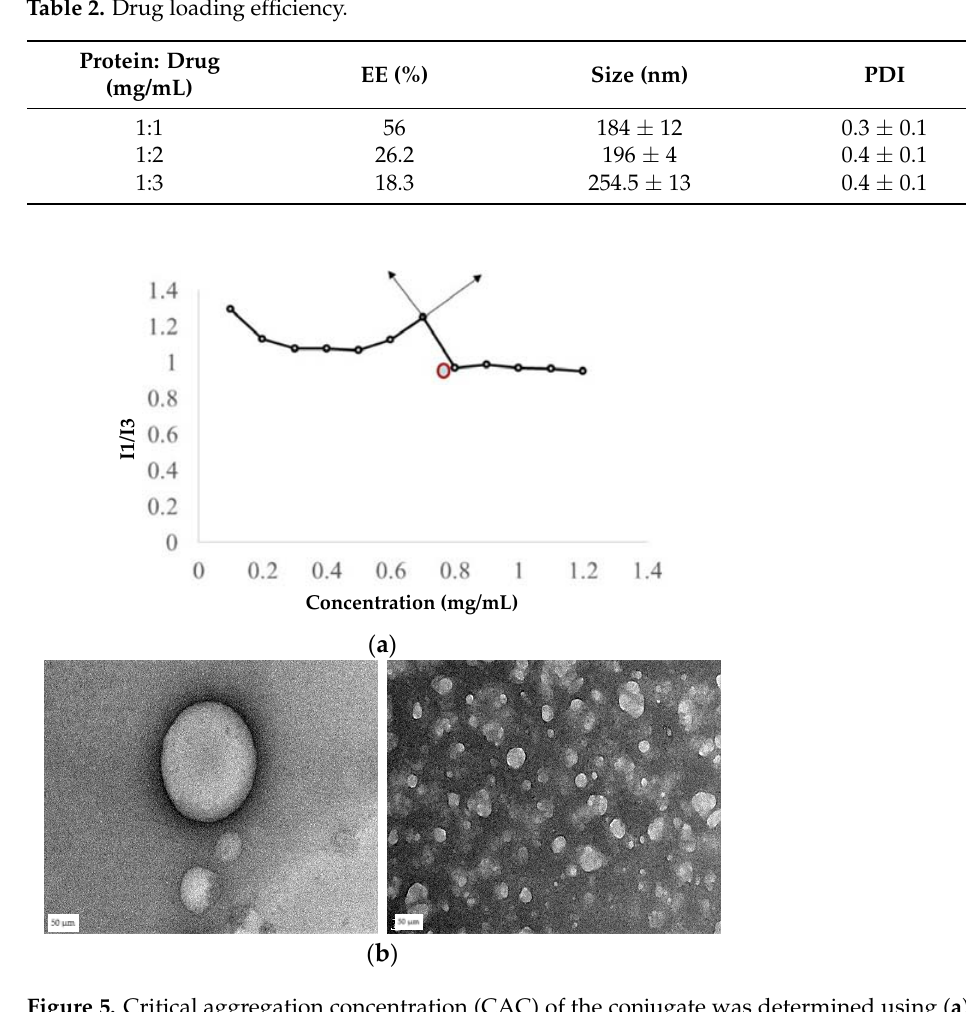
Figure 5. Critical aggregation concentration (CAC) of the conjugate was determined using ( a ) the standard pyrene fluorescence method. The concentration at the tangent on the graph, which shows a sudden fall in the intensity ratio, corresponds to the CAC (0.7 mg/mL). ( b ) TEM images of Vancomycin-loaded silk nanospheres show spherical nature of the particles.